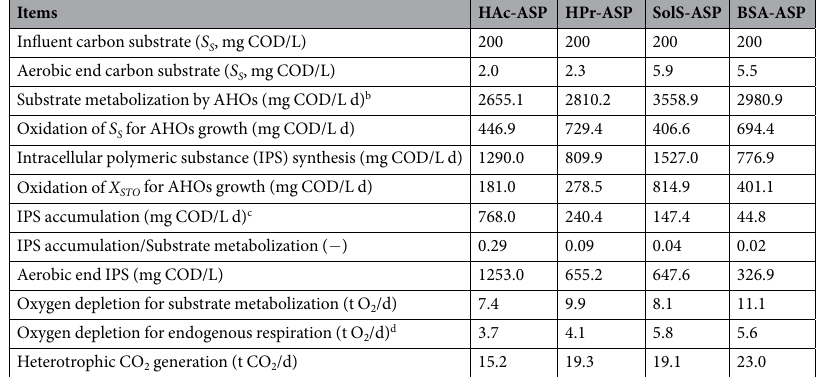
Table 1. Aerobic evolution of carbon substrates among other substances in the four ASPs a . a Removal rate of initial carbon substrate greater than 97% in the ASPs was used as a benchmark for comparative evaluation; consequently, HAc-, HPr-, SolS-, and BSA-ASP were operated at SRTs of 1.6, 2.7, 4.4, and 6.8 days, respectively. b Substrate metabolization includes the following three sub-processes mediated by AHOs: (i) oxidation of S for growth, (ii) utilization of S S for IPS synthesis ( X STO ), and (iii) aerobic degradation of X STO for growth. c IPS accumulation rate equals to the difference of IPS synthesis, degradation, and self-respiration. d Endogenous respiration herein includes the endogenous respiration of AHOs and self-respiration of X STO